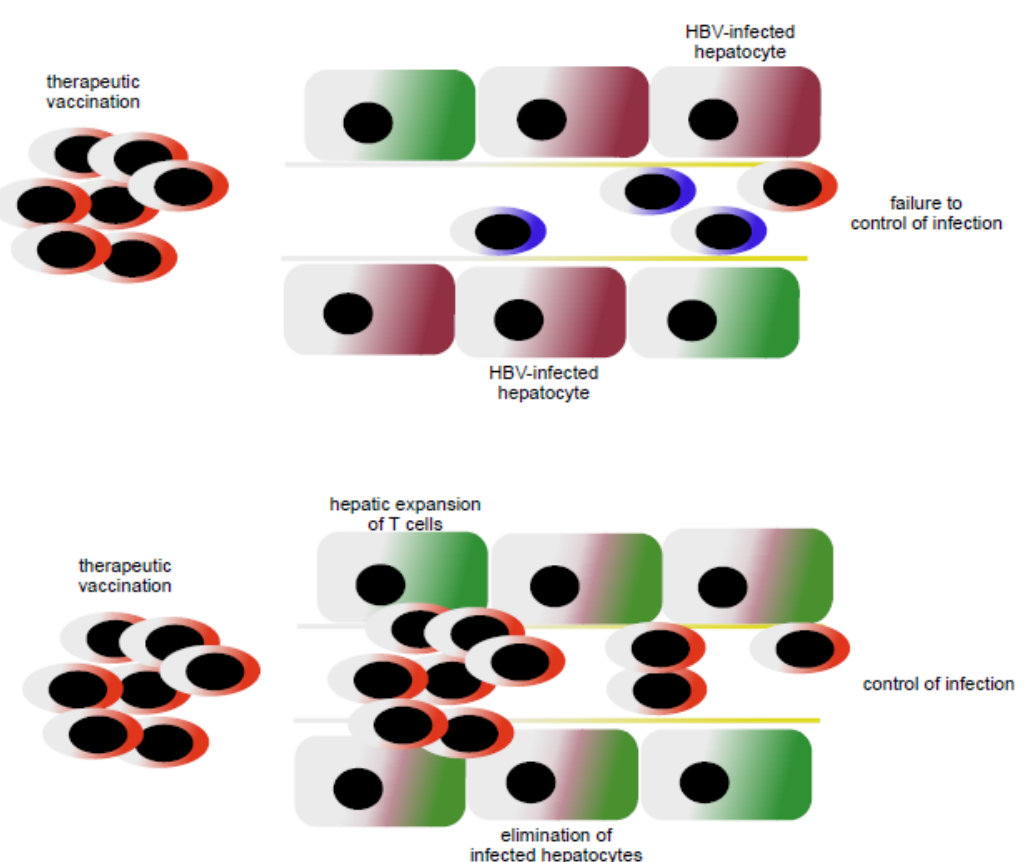
Figure 2. Virus-specific T cells generated by therapeutic vaccination in lymphoid tissues recognize virus-infected hepatocytes and eliminate infection if the numbers of hepatocytes are limited ( upper panel ), whereas therapeutic vac-cination fails to control viral infection if the numbers of hepatocytes are too high ( middle panel ). Combination of in-duction of virus-specific T cells in lymphoid tissue through therapeutic vaccination and local expansion of T cells in the liver acts synergistically to achieve control of infection ( bottom panel ).